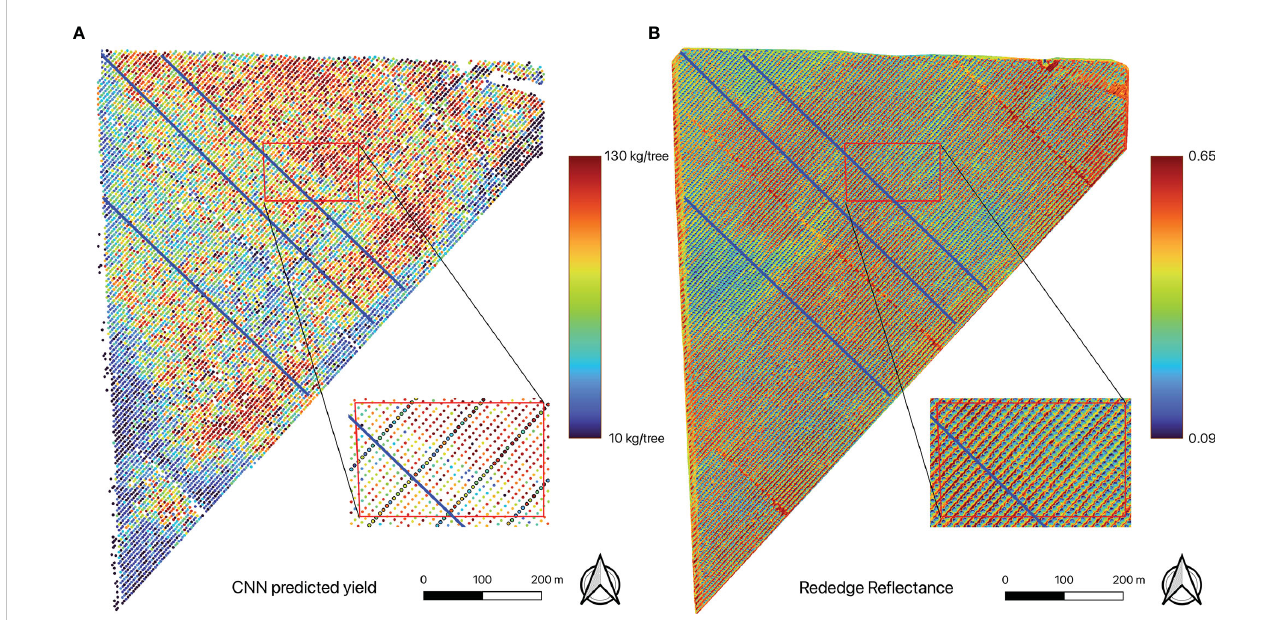
FIGURE 4 Maps of (A) individual tree yield estimated by the CNN mode, showing within- fi eld yield variation, and (B) red edge re fl ectance. A close-up of the yield map shows detailed spatial distribution of the estimated tree yield (those trees with ground yield measurement were indicated by black circles). Also shown are three transects (blue lines) for detailed tree-to-tree yield variation